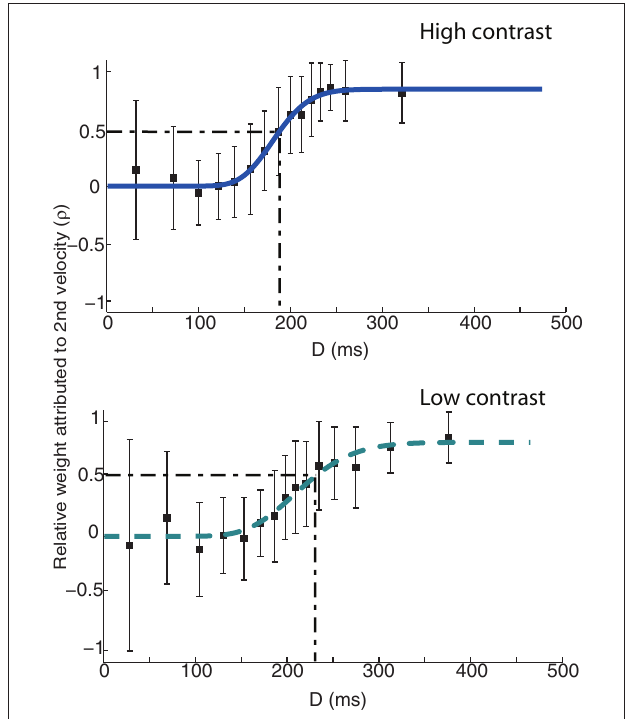
Figure 4 | r (the relative weight attributed to the post-step velocity) as n a function of D (time between velocity change and saccade onset) for a single observer. Dark blue solid line in the top panel denotes the fit of a cumulative Gamma function to the high contrast condition data. Light blue dashed line in the lower panel denotes a Gamma function fit to the low-contrast data. Error bars denote the SD. The dash–dot line in both plots denotes the time at which σ = 0.5, i.e., when both velocities are being n weighted equally. Note that while the data are presented here in approximately 15 equal bins, the actual Gamma fit was conducted on the full